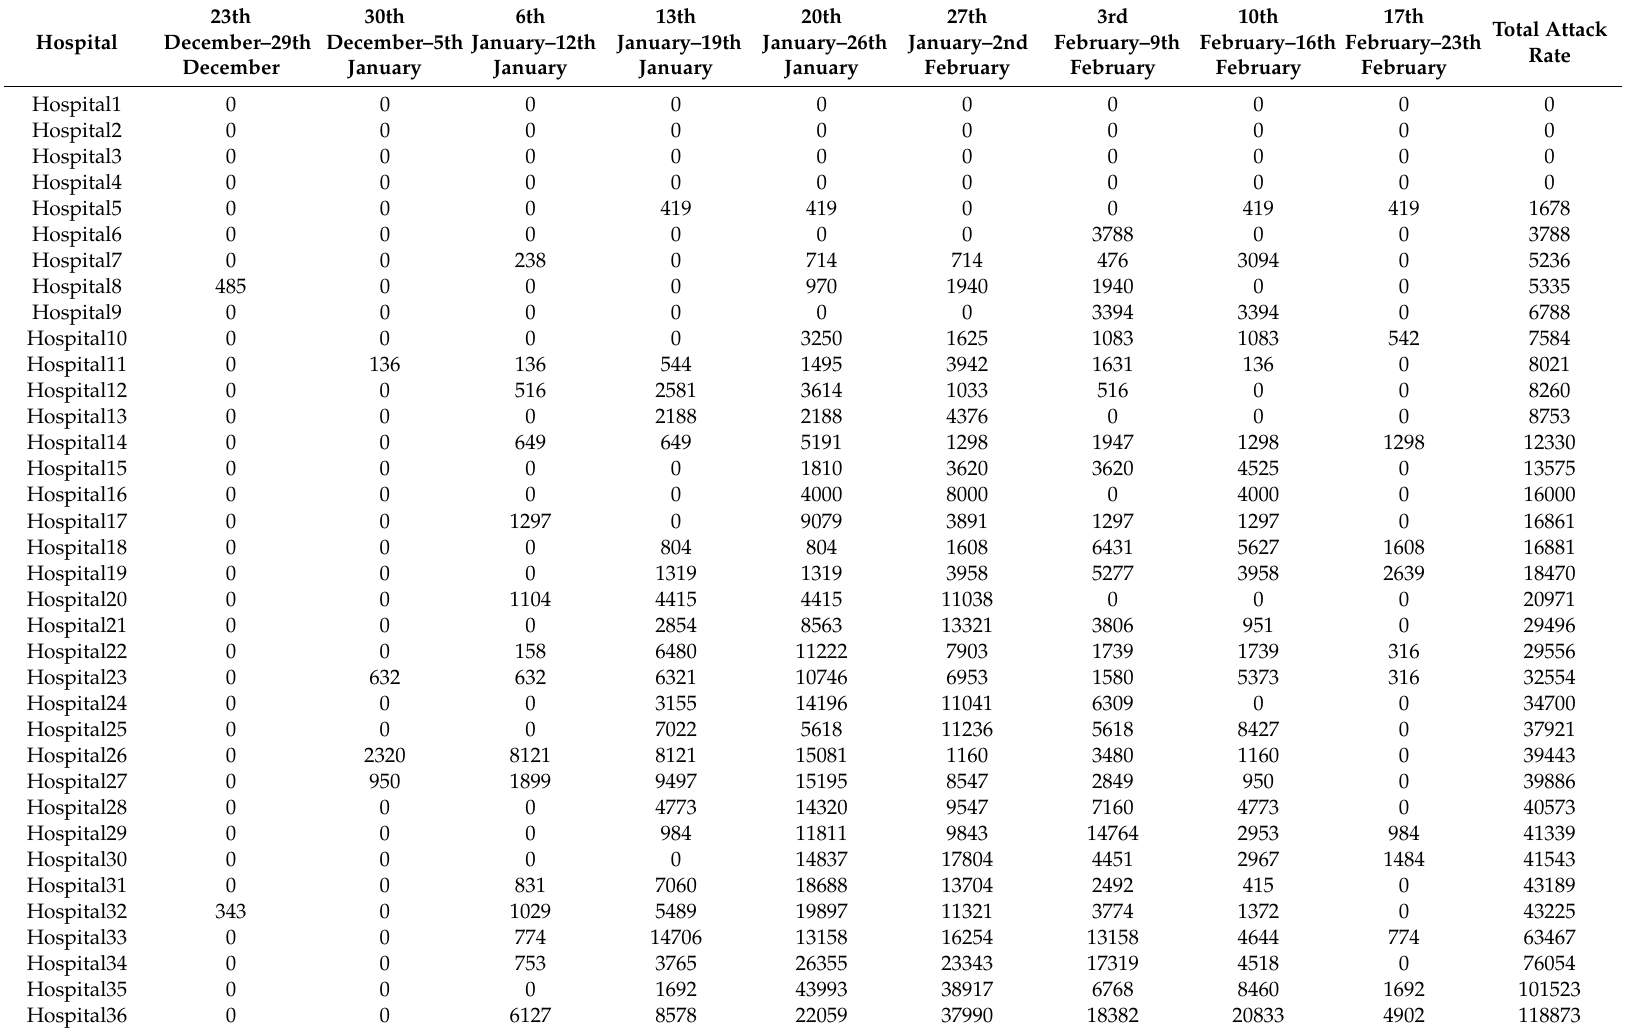
Table 2. Attack rates (per million people) of 36 main hospitals in Wuhan divided by the calendar time interval of a